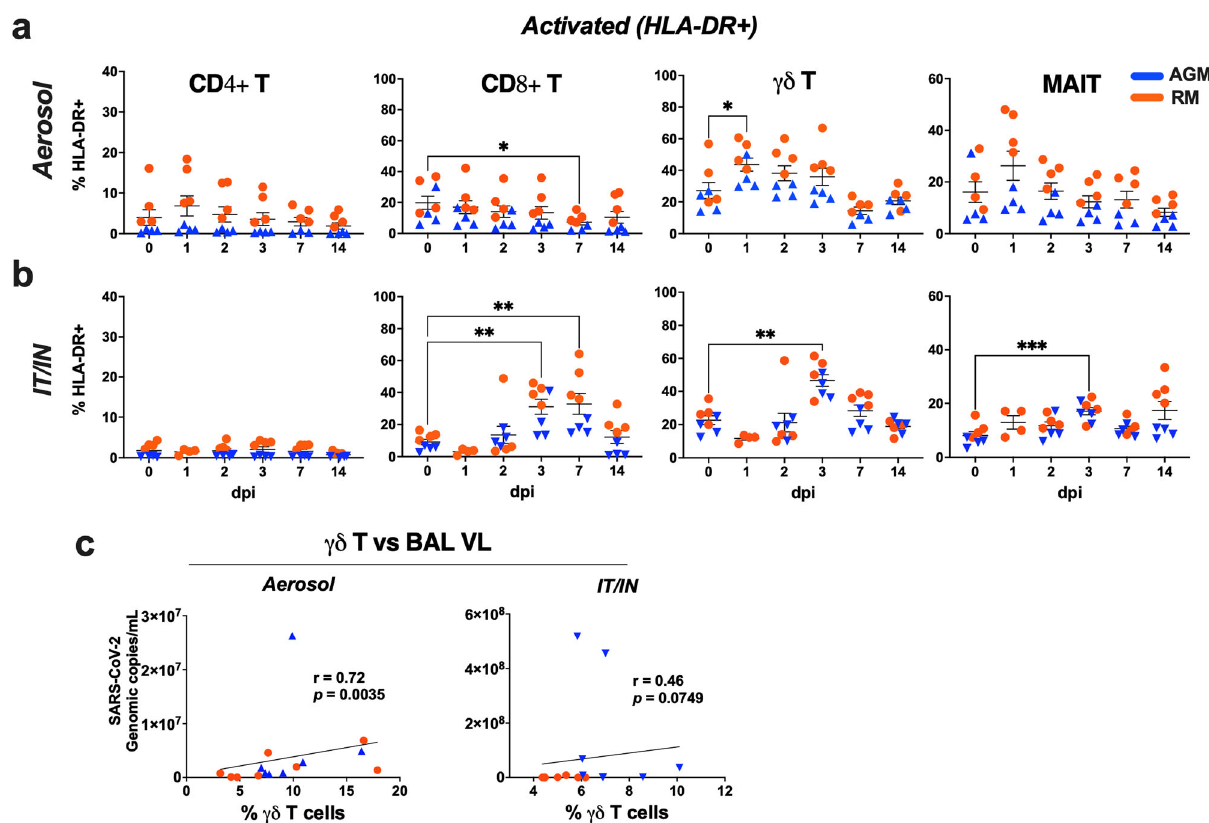
Fig. 3 Activation kinetics of circulating T lymphocyte subsets and correlation with lung viral loads during early SARS-CoV-2 infection via aerosol and IT/IN route in NHPs. Frequencies of CD4 T, CD8 T, γδ T, and MAIT cells in PBMCs isolated from RM and AGM in aerosol ( a ) or IT/IN group ( b ), showing a rapid increase in activated γδ T cells in the aerosol group ( n = 8/group). Graphs show mean and SEM. Comparisons of different time points with respect to d0 baseline data were done using repeated measures one-way ANOVA with Dunnett ’ s post hoc tests. Asterisks indicate signi fi cant differences between time points ( p < 0.05; ** p < 0.01). c Spearman Rank correlation between BAL viral loads with frequencies of total γδ T cells in the fi rst week of infection. Individual values shown for each animal as symbols in orange for RMs and blue for